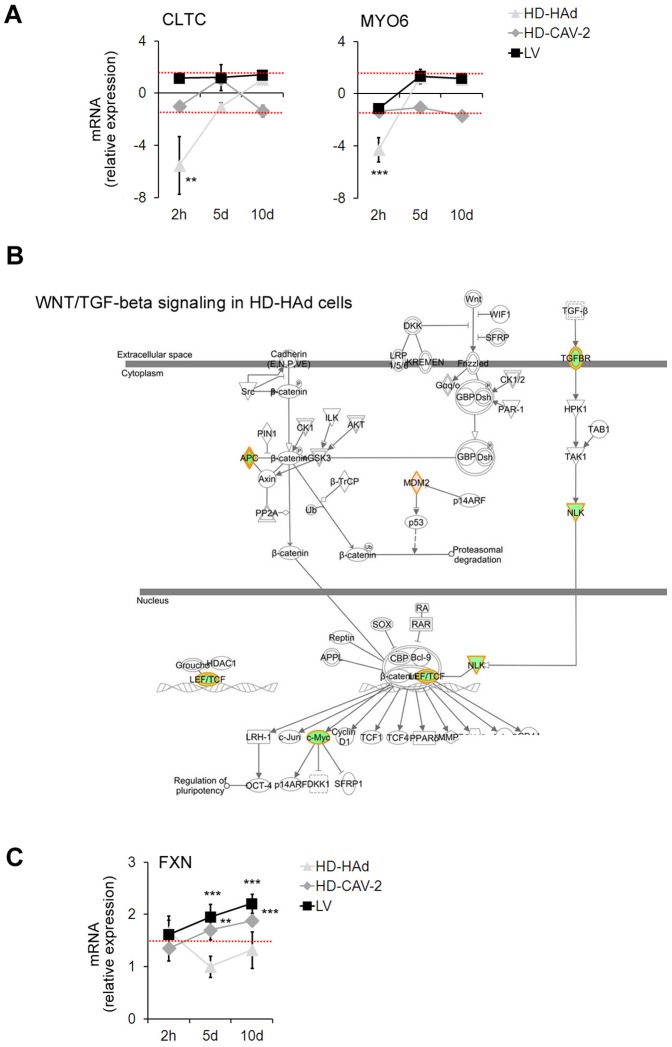
Downregulation of endocytotic and Wnt genes in HD-HAd cells.(a) CLTC and MYO6 modulations were evaluated by qPCR at 2 h, 5 and 10 days posttransduction. Data are presented as fold change expression of each transcript normalized with respect to the endogenous control and calculated as compared to the mock sample considered as 1. Red dashed lines display the threshold set at ±1.5, as for microarray data. Data are reported as mean with SD. All samples were tested in triplicate; one-way ANOVA (vectors versus mock), ** p<0.01, , *** p<0.001. (b) Wnt/TGF-β pathway in HD-HAd cells 2 h posttransduction. In red are highlighted the upregulated genes, in green the downregulated ones, in white genes not modulated in the chip; IPA p-value 4.01×10−2. A detailed legend is in figure 4c. (c) FXN modulation quantified by qPCR at 2 h, 5 and 10 days days posttransduction. Data are presented as fold change expression of each transcript normalized with respect to the endogenous control as in (a).